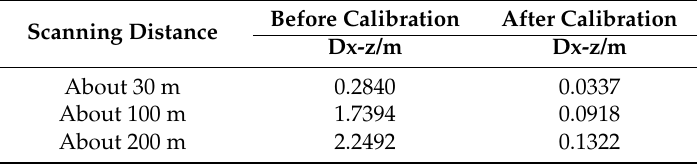
Figure 6. The rectified result with boresight calibration (the 12 CGPs are marked on it). Table 4. The change of the positional errors with scan distance.